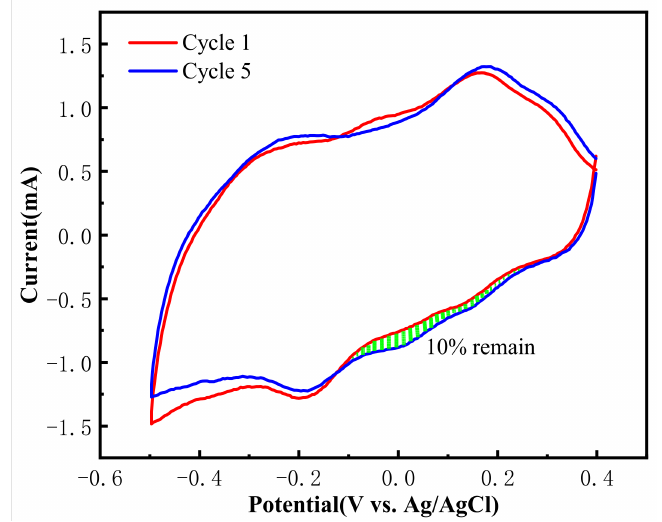
Figure 10. Cyclic voltammograms of PAQ/MWCNTs composite electrodes after 120 ◦ C thermal release.